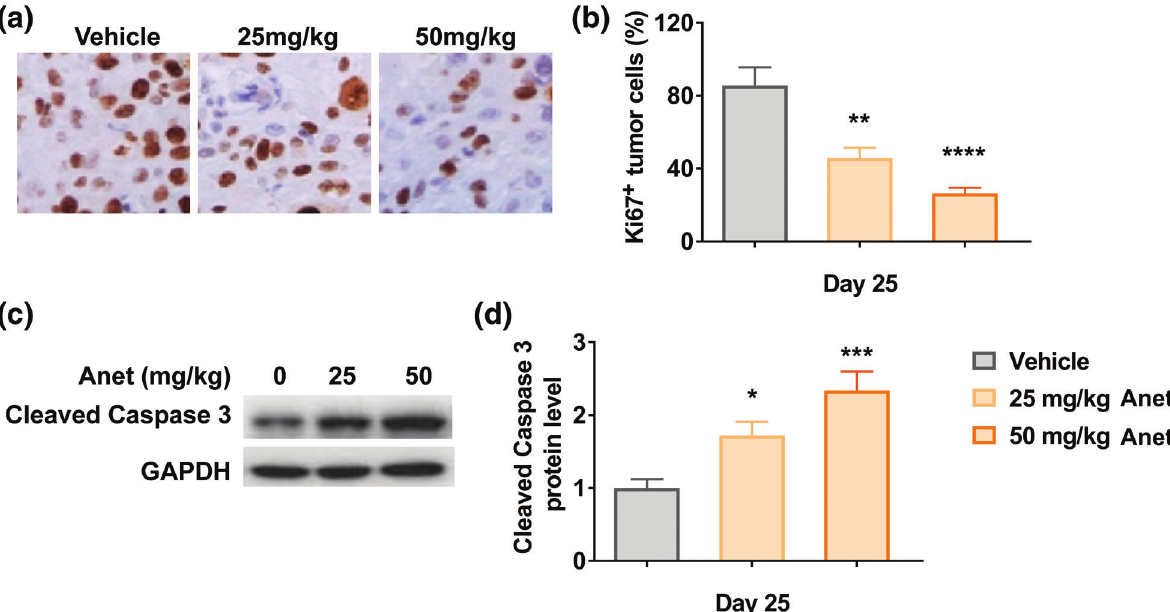
Fig. 6. Anethole inhibited the proliferation and promoted the apoptosis of A549 tumor in vivo . A549 tumor-bearing mice were treated by vehicle, 25, or 50 mg/kg anethole. The tumors were harvested at day 25 to analyze the expression levels of Ki67 (a and b) by IHC and cleaved Caspase 3 (c and d) by Western blot. n = 7 for each group. Error bar represents SEM. * P < 0.05, *** P < 0.01, *** P < 0.001, and **** P < 0.0001.